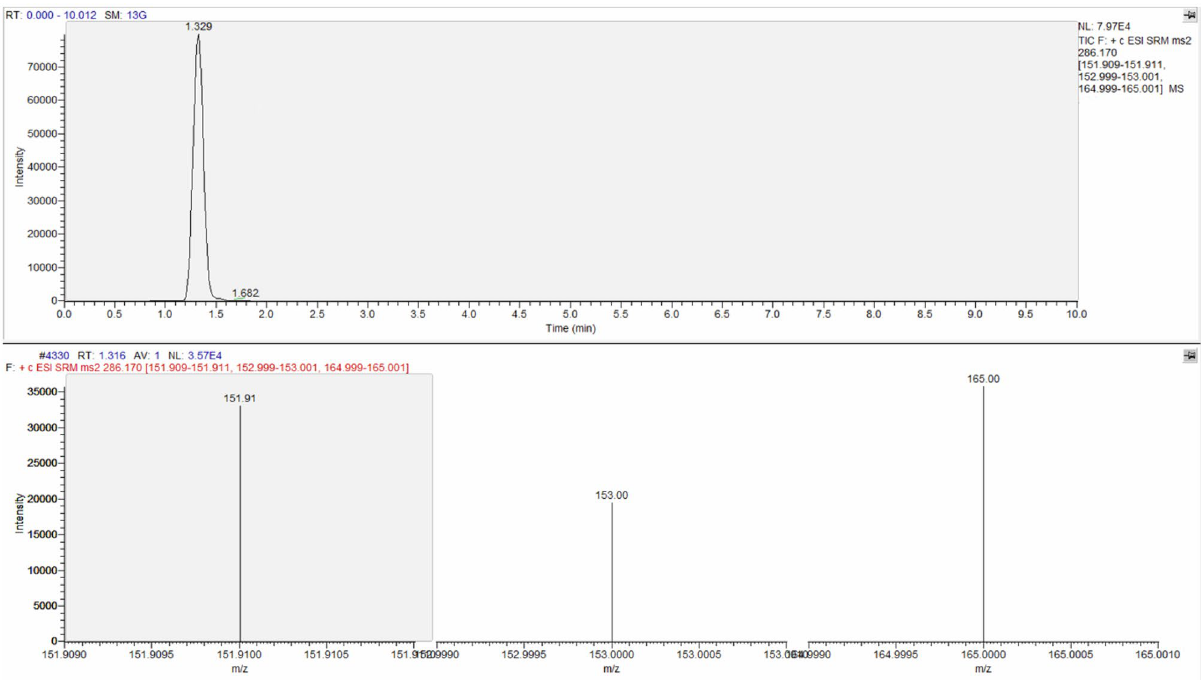
Figure 4. Chromatographic spectrum (upper lane) and mass spectral ion ratio (lower lane) of morphine detected in C4.